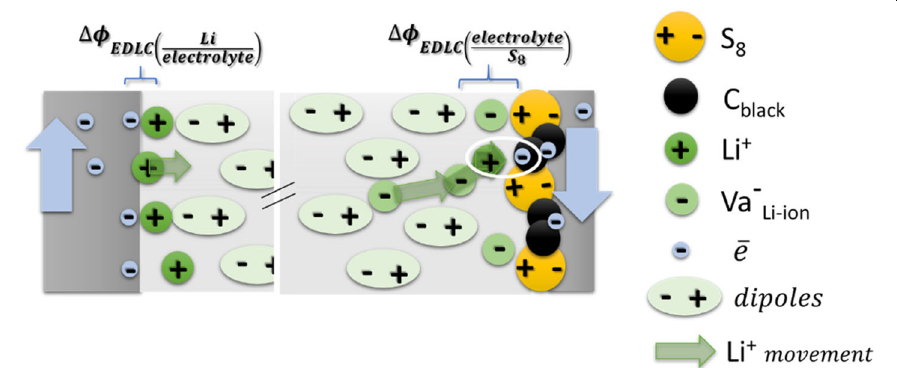
Fig. 5 Schematic of EDLCs at the electrode and electrolyte interfaces during discharge where electric dipoles coexist with the mobile cations and negatively charged vacancies in the electrolyte. The positive electrode ’ s incoming electrons tunnel through the quantum triangular barrier formed by the EDLC that equalizes its electrochemical potential of the electrolyte with the electrochemical potential of the positive electrode; each tunneling electron reduces a Li + into Li 0 . The dipoles help to keep the ions confined at the